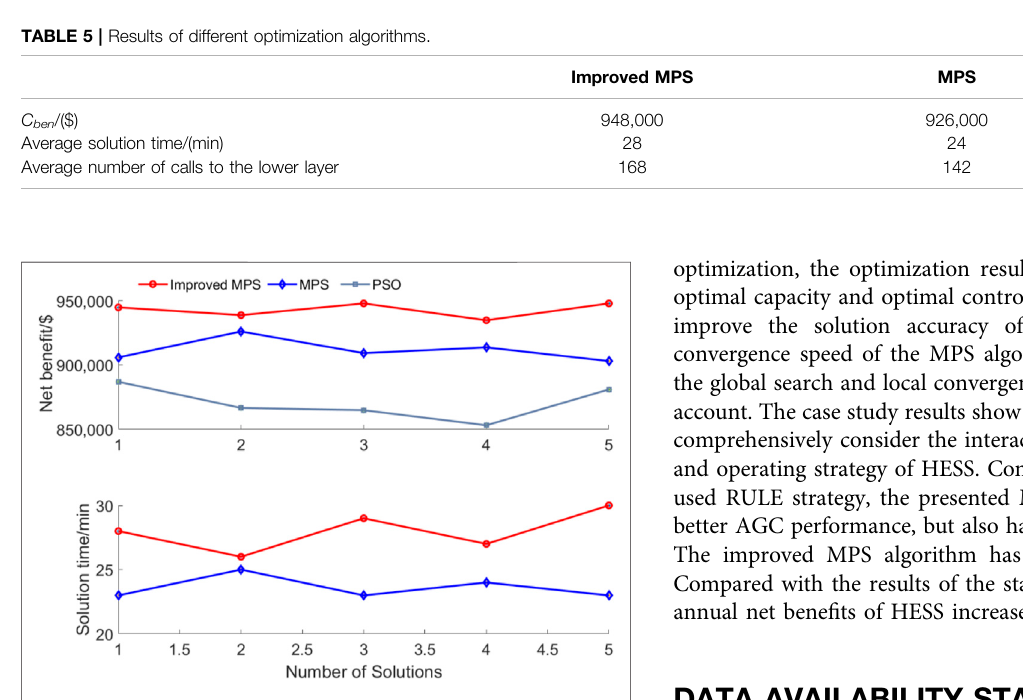
FIGURE 7 | Comparison of fi ve calculation results of three